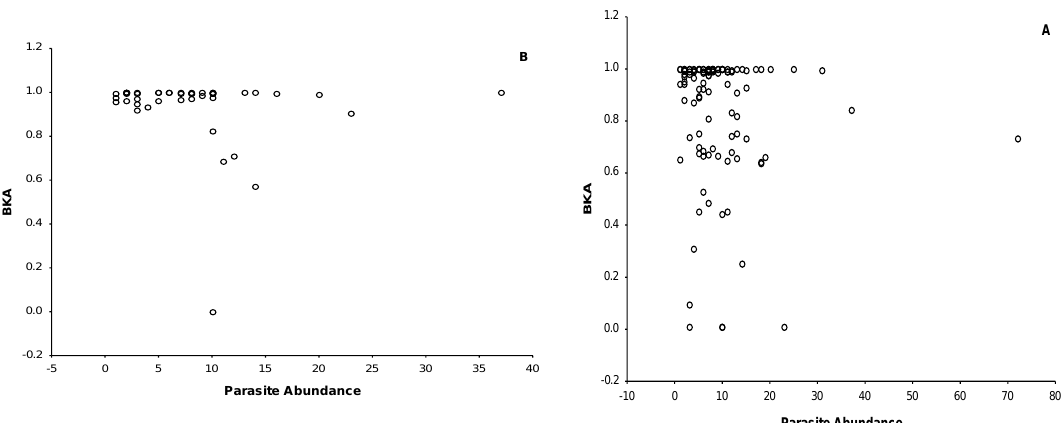
Figure 7. Spearman Rank correlation analyses between bacterial killing ability (BKA) and ectoparasite abundance in female ( A ) and male ( B ) bats in Partida Norte Island, Mexico. Parasite abundance was significantly correlated only with BKA in males.